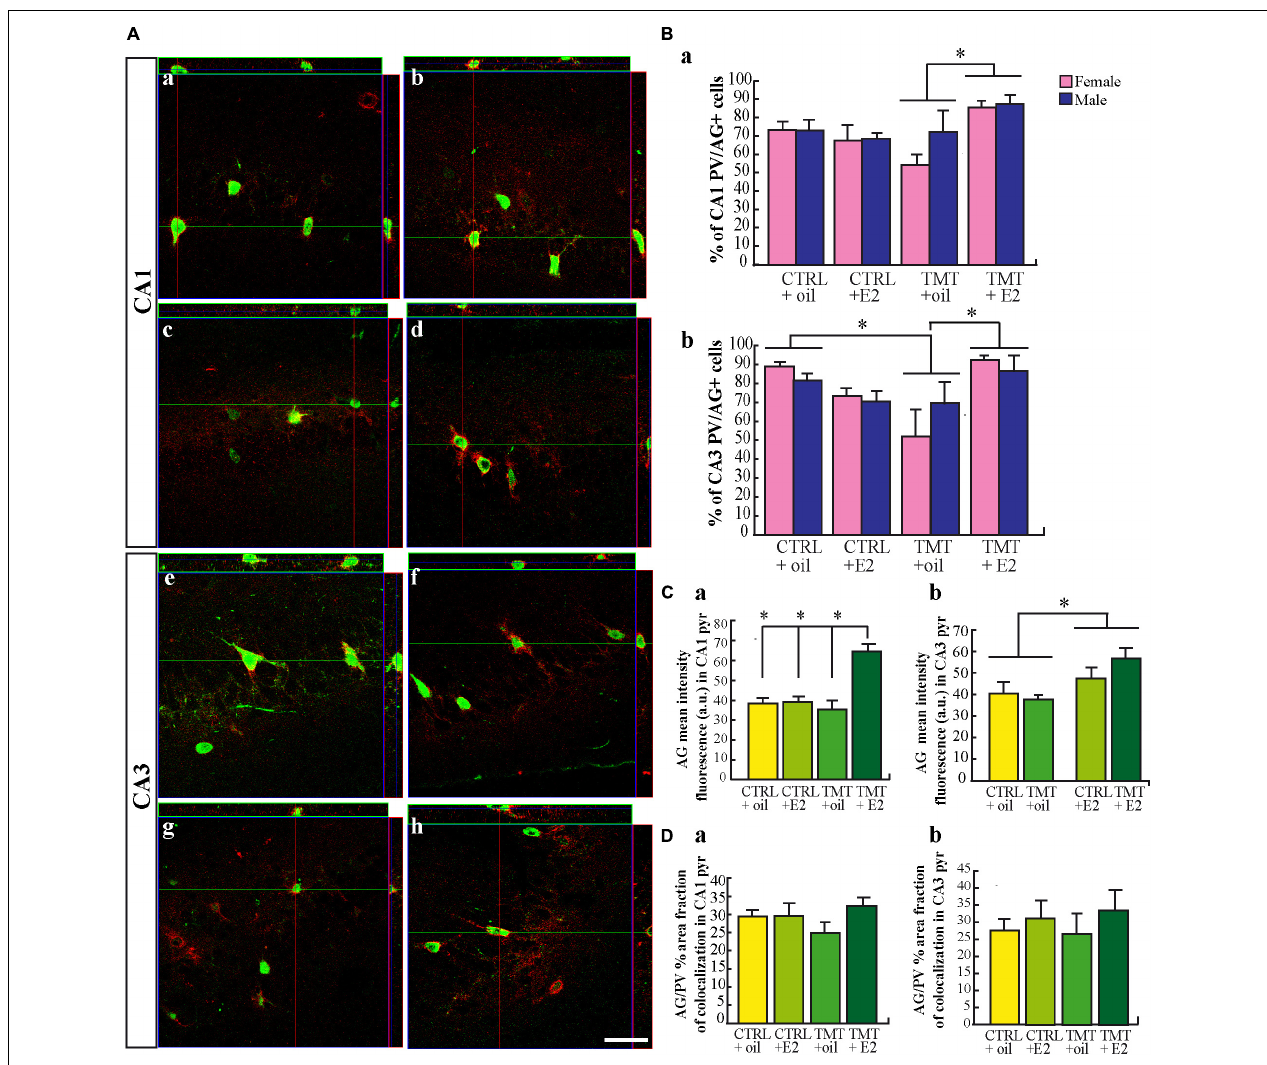
FIGURE 5 | Aggrecan (AG) expression in the hippocampi of the different experimental groups. (A) Representative confocal reconstructed orthogonal images, as viewed in the x-z (top) and y-z (right) planes of 40 µ m sagittal sections from CA1 (a–d) and CA3 (e–h) hippocampal subfields of CTRL+oil- (a,e) CTRL+17 β -estradiol (E2)- (b,f) , TMT+oil- (c,g) , TMT+E2- (d,h) treated rats, double-labeled for parvalbumin (PV) (green) and AG (red). Scale bar: 90 µ m in (a–d) , 100 µ m in (e-h) . (B) Percentage of PV/AG-positive neurons in the CA1 and CA3 pyramidal layer of CTRL+oil-, CTRL+E2-, TMT+oil-, TMT+E2- treated rats. In the CA1 region quantitative analysis followed by three-way ANOVA indicates a significant effect of both E2 administration ( F 1 , 18 = 4.42 p < 0.001) and TMT ∗ E2 interaction ( F 1 , 18 = 13.9, p < 0.05), while no significant difference related to sex emerged ( F 1 , 18 = 1.5, p > 0.05). TMT+E2-treated rats (M-TMT+E2 and F-TMT+E2) exhibited a significantly higher percentage of PV/AG-double labeled interneurons compared with TMT+oil groups (M-TMT+oil and F-TMT+oil; Tukey post hoc p < 0.05). No differences related to sex are present ( F 1 , 18 = 0.15, p > 0.05) (a) . Statistical analysis performed in CA3 pyramidal layer (b) showed a significant TMT ∗ E2 interaction (three-way ANOVA F 1 , 18 = 11.62, p < 0.05), pointing out a reduced percentage of PV/AG co-localization in TMT+oil rats (M-TMT+oil and F-TMT+oil) compared with CTRL+oil groups (F-CTRL+oil and M-CTRL+oil, Tukey post hoc p < 0.05), while the TMT+E2-treated group showed a percentage of PV/AG co-localization significantly higher than TMT+oil groups (Tukey post hoc p < 0.05) and similar to that in CTRL groups (Tukey post hoc p > 0.05). No differences related to sex are present ( F 1 , 18 = 0.01, p > 0.05). The values are given as means ± SE ( ∗ p < 0.05). (F-CTRL+oil n = 3; M-CTRL+oil n = 3; F-CTRL+E2 n = 4; M-CTRL+E2 n = 3; F-TMT+oil n = 4; M-TMT+oil n = 3; F-TMT+E2 n = 3; M-TMT+E2 n = 3). (C) Mean fluorescence intensity of PV/AG stained cells in the hippocampi of the different experimental groups. Bar graphs indicate the mean fluorescence intensity of PV/AG+ neurons in both CA1 (a) and CA3 (b) hippocampal subfields of CTRL+oil-, CTRL+E2-, TMT+oil-, TMT+E2- treated animals. In the CA1 subfield (pyramidal layer), two-way ANOVA showed a significant effect of both TMT treatment ( F 1 , 20 = 8.18, p < 0.05) and E2 administration ( F 1 , 20 = 18.16, p < 0.001); TMT ∗ E2 interaction ( F 1 , 20 = 16.02; p < 0.001) was also significant. Tukey post hoc test showed a significant increase in the mean fluorescence intensity of AG-positive cells in the TMT+E2-treated groups compared with all other experimental groups ( p < 0.001, for all comparisons) (a) . In the CA3 region, only the significant effect of E2 administration was detectable (two-way ANOVA, F 1 , 20 = 9.72, p < 0.05 Tukey post hoc p < 0.05) thus indicating an increased mean fluorescence intensity of AG in both groups of E2-treated animals (b) . The values are given as means of pooled sex groups (male + female) ± SE both in (C,D) ( ∗ p < 0.05, ∗∗ p < 0.001) ( n = 6 animals/each experimental group). (D) Quantitative analysis of percentage of fraction area in PV/AG-stained cells. No significant differences in the percentage of fraction area emerged among the different experimental groups both in the CA1 (a) and CA3 (b) subfields (two-way ANOVA, p > 0.05). The values are given as means of pooled sex groups (male + female) ± SE both in (C,D) ( ∗ p < 0.05, ∗∗ p < 0.001) ( n = 6 animals/each experimental